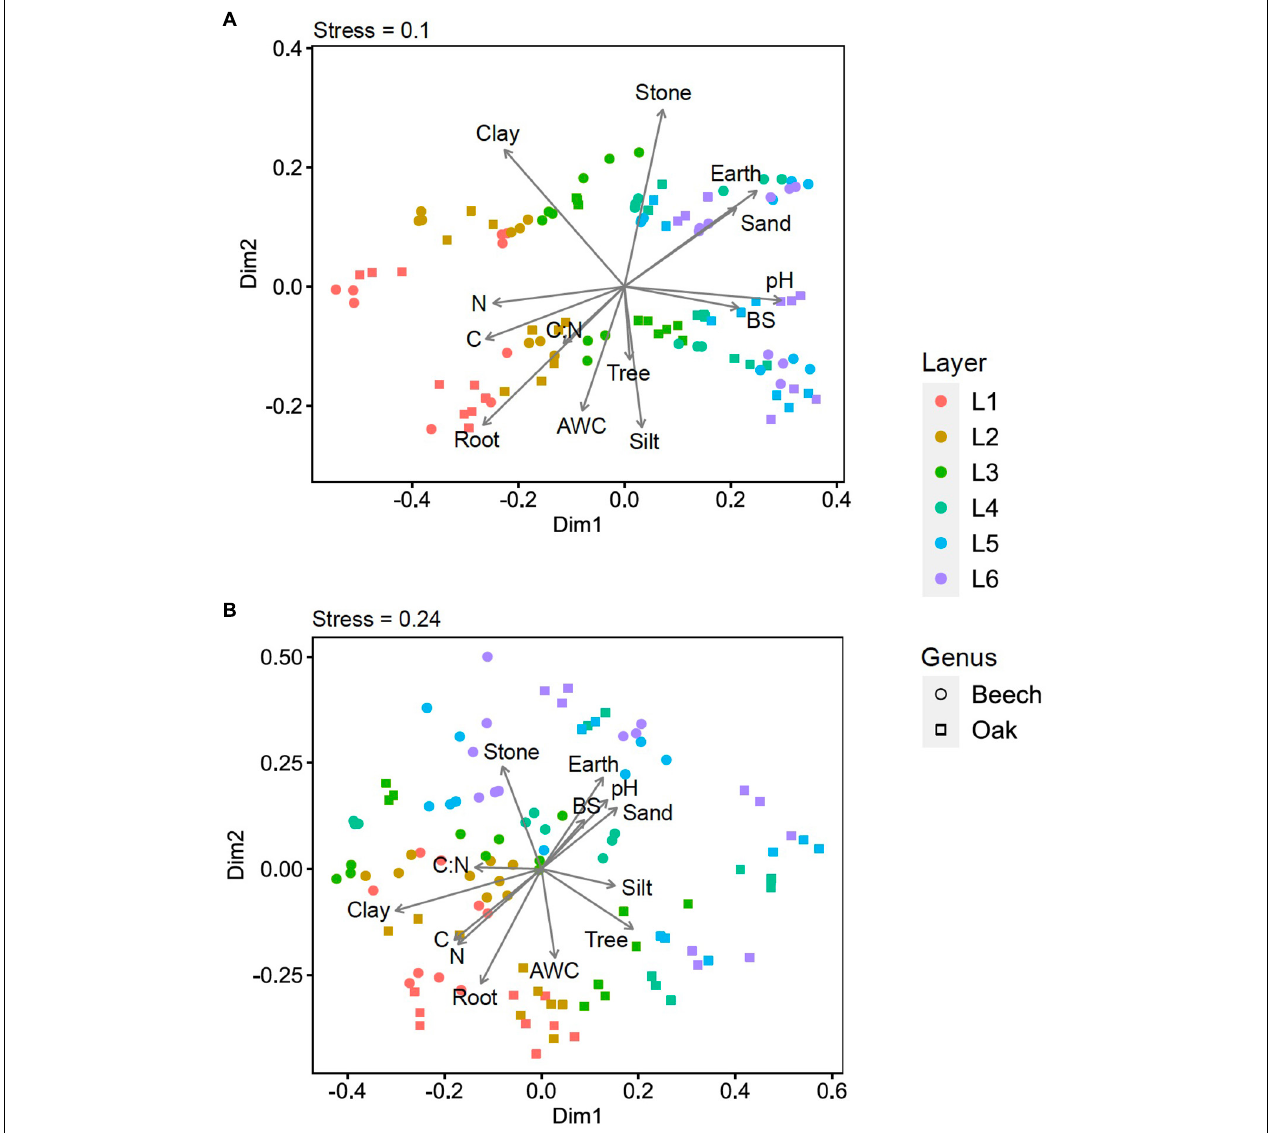
FIGURE 3 | Non-metric multidimensional scaling (NMDS) ordination based on Bray–Curtis dissimilarities for (A) bacterial and (B) fungal communities in various soil layers (L1–L6) of beech and oak sites. Soil environmental variables were projected as arrow vectors onto the NMDS ordinations. Vector arrowheads show the direction of variation of the soil variables, and vector lengths reflect the strength of the correlation of the variables with the NMDS axes. AWC: plant-available water storage capacity, BS, base saturation; C, C org ; Clay, clay content; CN, C:N ratio; Earth, fine-earth density; N, N tot ; pH, pH (CaCl 2 ); Root, fine-root biomass; Sand, sand content; Silt, silt content; Stone, stone content; Tree, tree genus. Soil layers: L1: 0–10 cm, L2: 15–25 cm, L3: 45–55 cm, L4: 75–85 cm, L5: 110–125 cm, L6: 140–155 cm (for explanations see Table